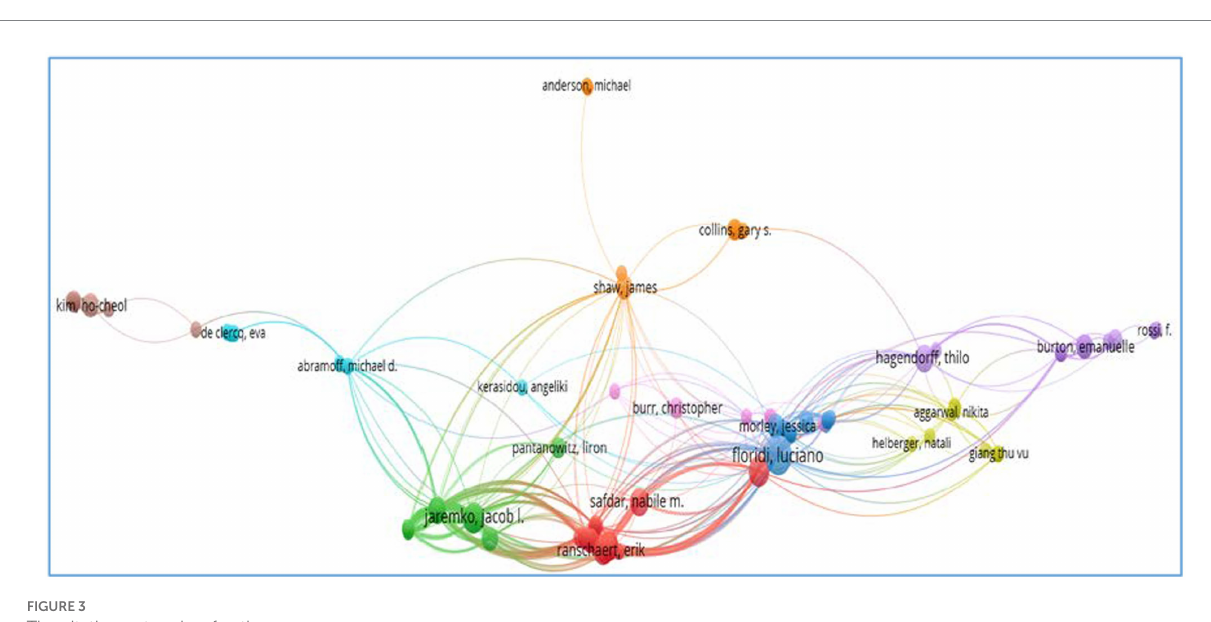
FIGURE 3 The citation networks of